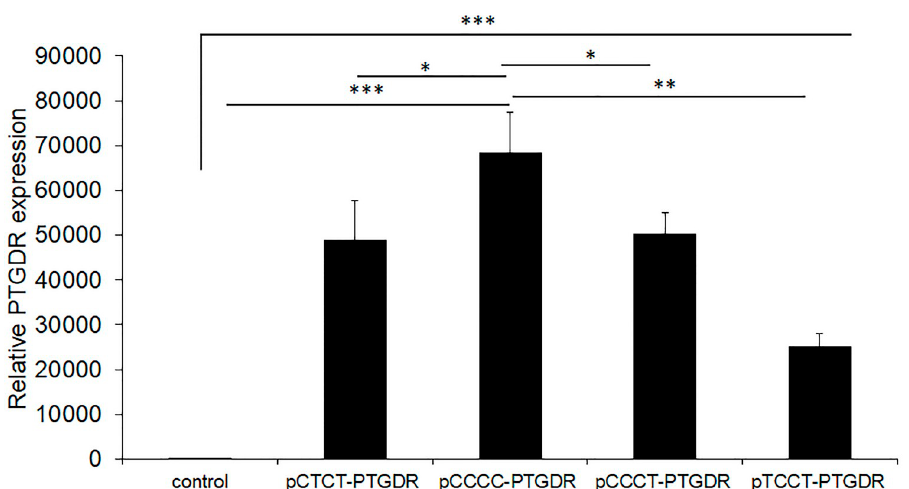
Fig 1. Quantitative real-time PCR analysis of PTGDR gene expression. A549 cells were transfected with pCTCT-, pCCCC-, pCCCT- or pTCCT- PTGDR expression vectors and with carrier DNA (control condition). Cells were collected after 24h followed by qPCR analysis of PTGDR gene. PTGDR gene expression was normalized to GAPDH mRNA levels. ( ��� p < 0.001 for transfected cells with the haplotypic variants versus control. ( �� P < 0.01, for the CCCC- PTGDR transfected cells versus TCCT- PTGDR , and � P < 0.05 versus CTCT and CCCT respectively).